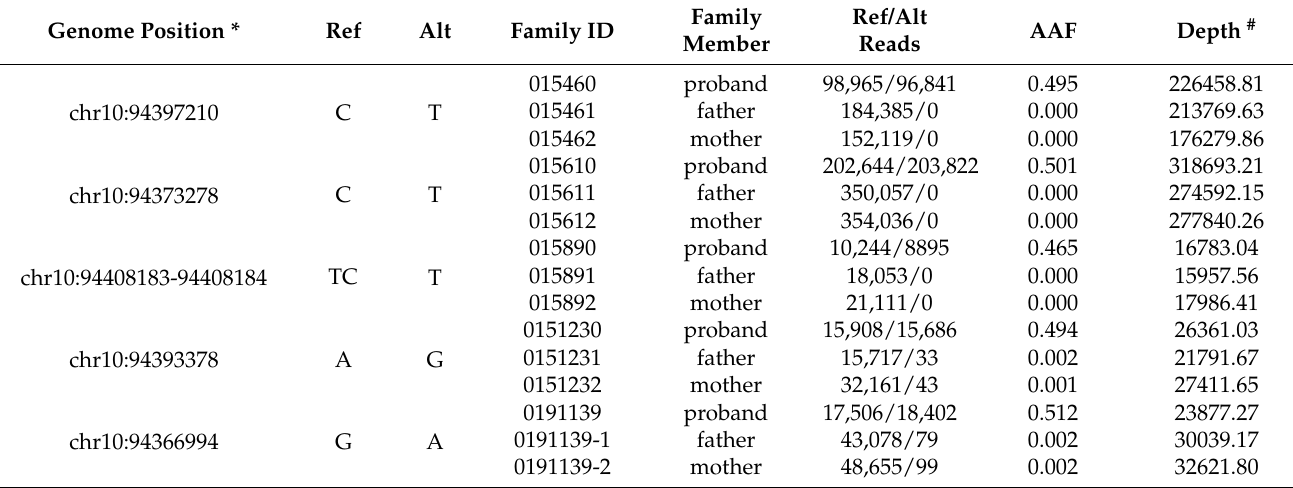
Table 2. The alternate allele frequency and average sequencing depth in all